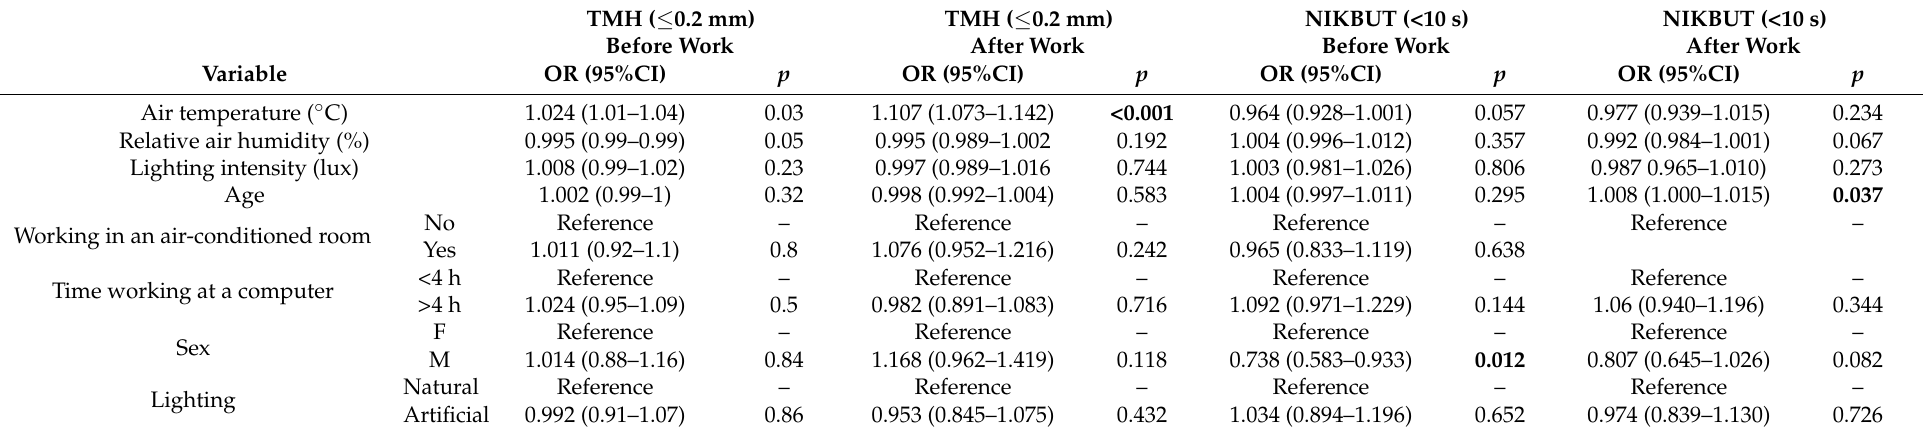
Table 5. Multivariable logistic regression to determine the influence of temperature, relative air humidity, and lighting intensity on the incorrect results of the eye surface